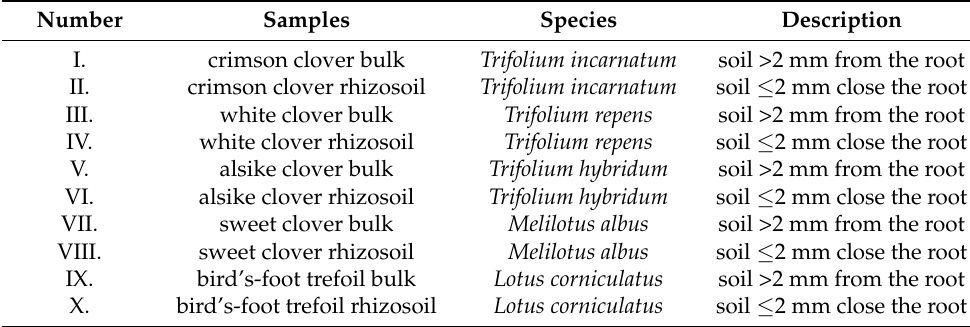
Table 2. Samples according to the species and root-soil